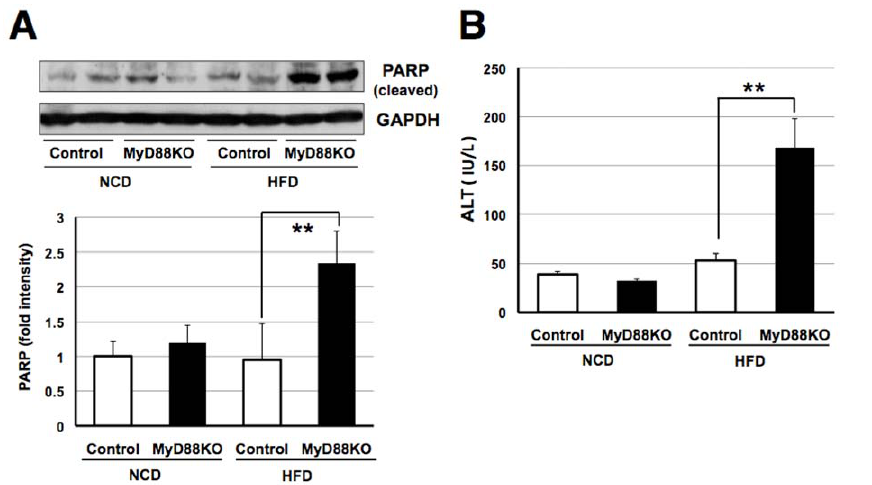
Figure 6. MyD88-deficient mice fed the HFD developed liver dysfunction. ( A ) Western blot analysis of cleaved PARP in liver samples at the age of 18 weeks. Each genotype of mice was fed the NCD (n=7) or HFD (n=6–8). ** p , 0.01 ( B ) Serum ALT levels were measured at the age of 18 weeks. Each genotype of mice was fed the NCD (n=8) or HFD (n=6–7). ** p , 0.01.